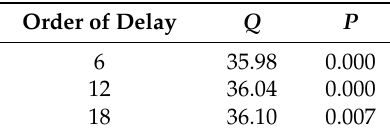
Table 9. White noise test results after differential